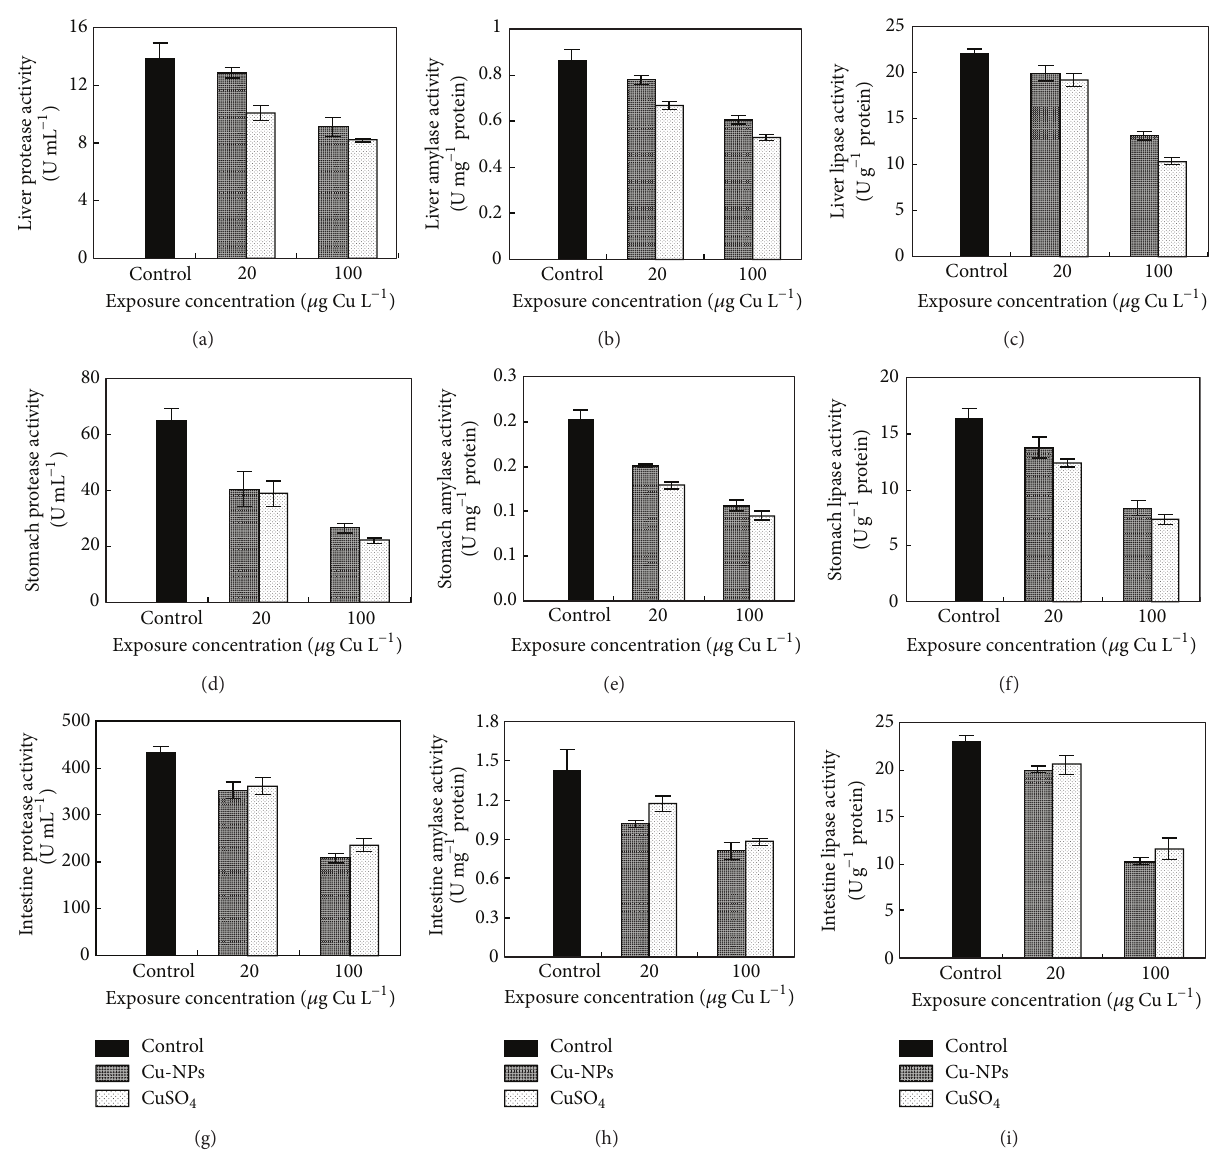
Figure 1: Effects of Cu-NPs and CuSO 4 on digestive enzyme activities (protease ((a), (d), (g)), amylase ((b), (e), (h)), and lipase ((c), (f), (i)) in liver ((a)–(c)), stomach ((d)–(f)), and intestines ((g)–(i)) of juvenile Epinephelus coioides after 25-day exposure.